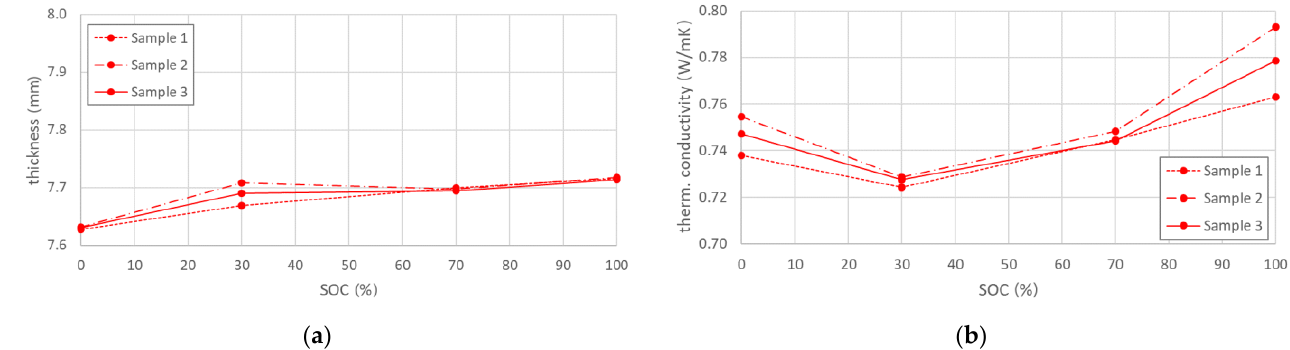
Figure 1. ( a ) Cell thickness variation over SOC for fresh cells ( b ) Calculated thermal conductivity of fresh cells, showing a negative parabolic behavior with SOC increase.